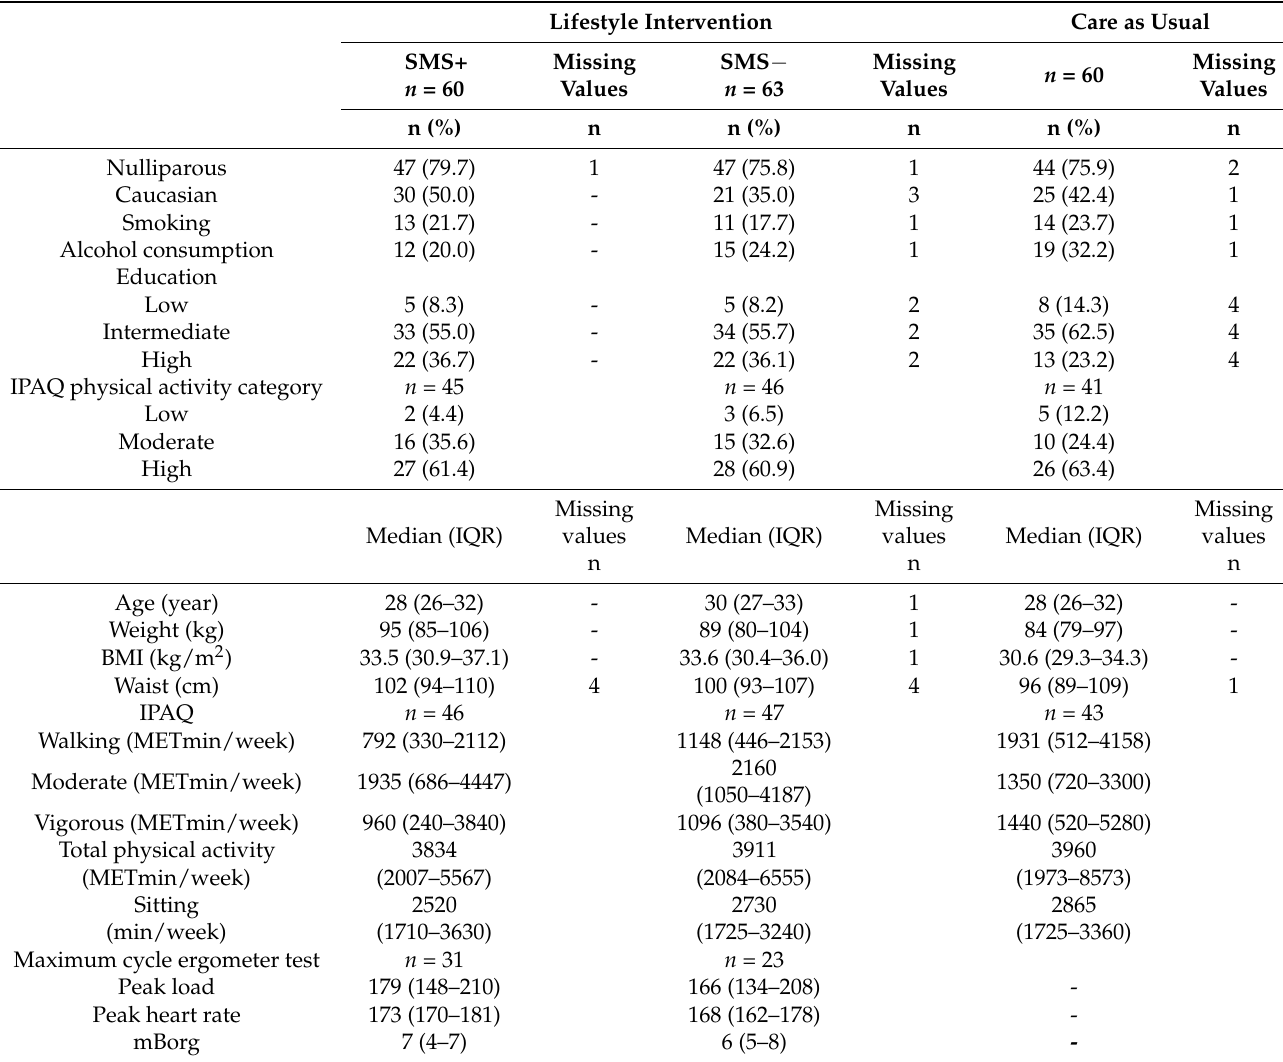
Table 2. Baseline